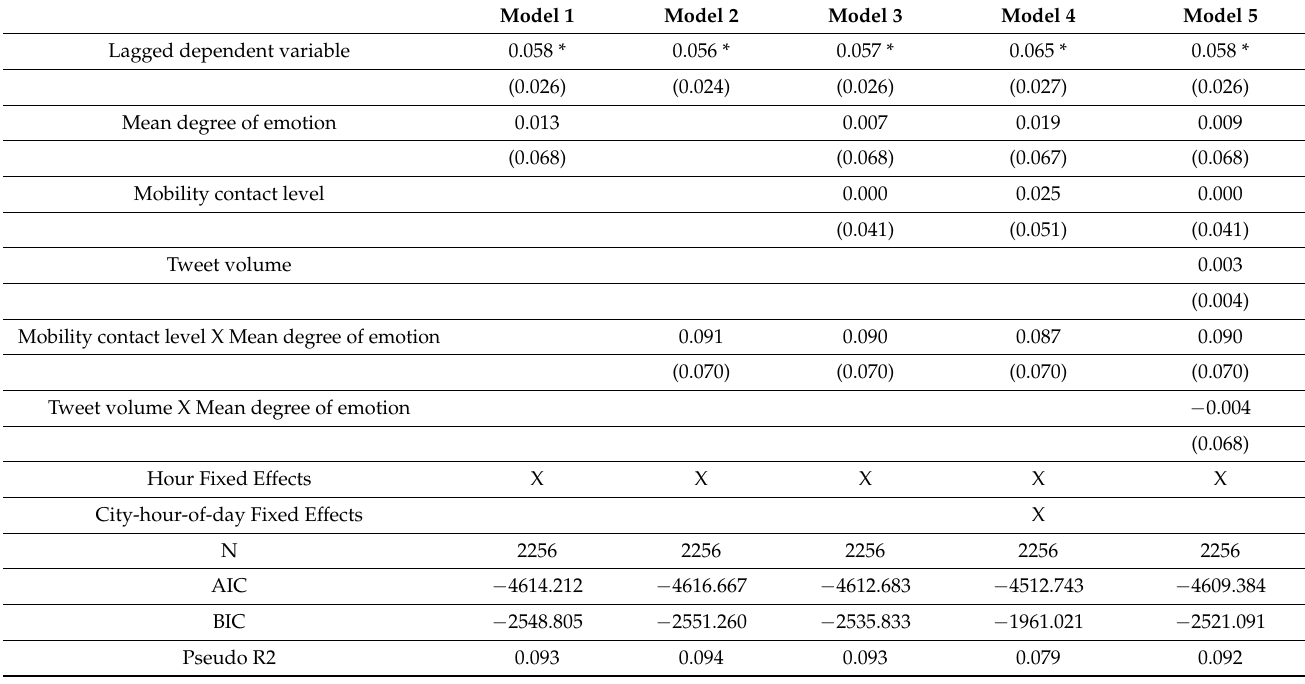
Table 2. General sentiment